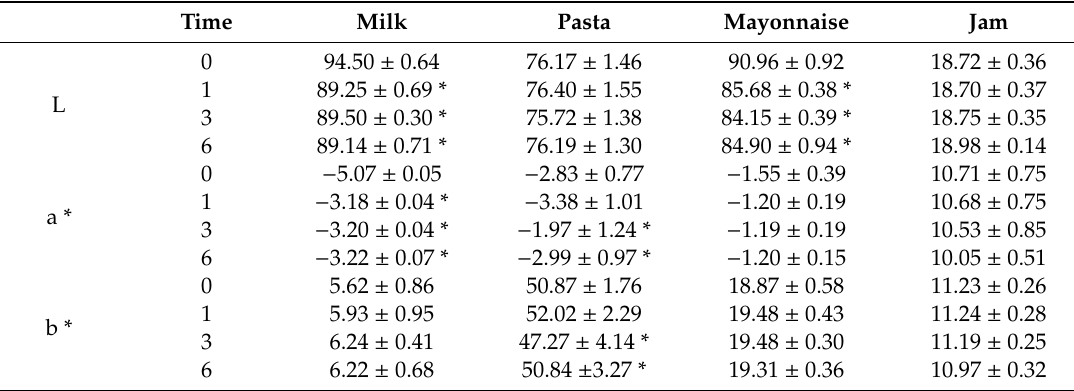
Table 8. Changes in colour parameters of the tested food